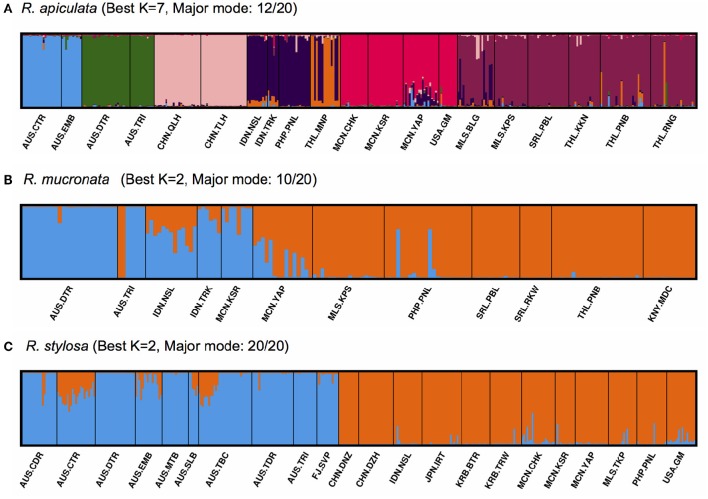
Structure bar plots showing the assignment of individuals in Rhizophora. Each vertical bar represents one individual, and different colors within each bar indicate admixture. (A)
R. apiculata (best K = 7); (B)
R. mucronata (best K = 2); (C)
R. stylosa (best K = 2).